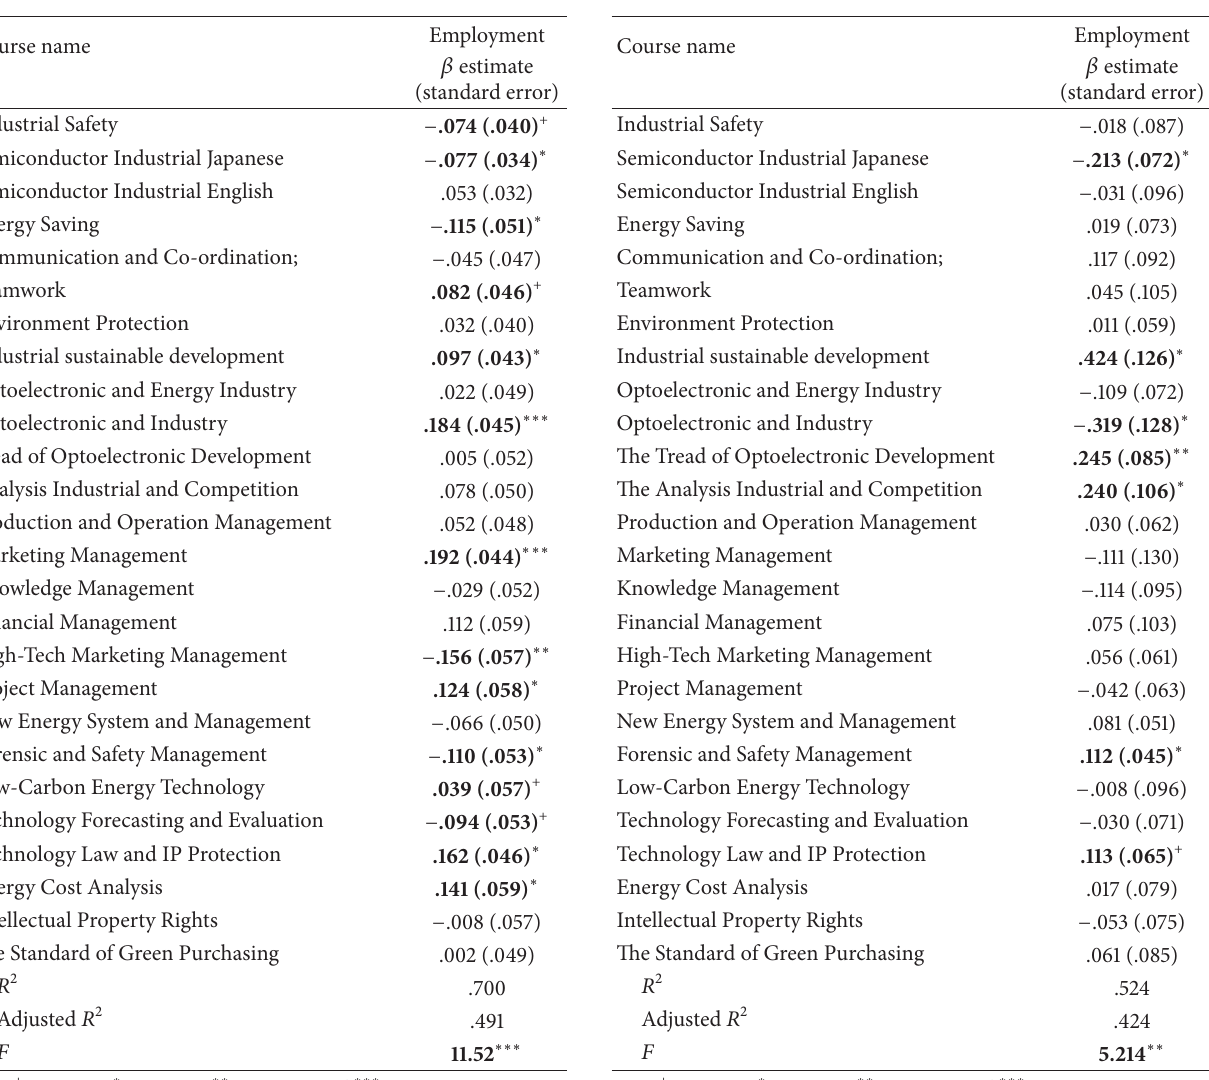
Table 14: Multiple regression analysis—affective domain curricu- lum on employability (university sample).